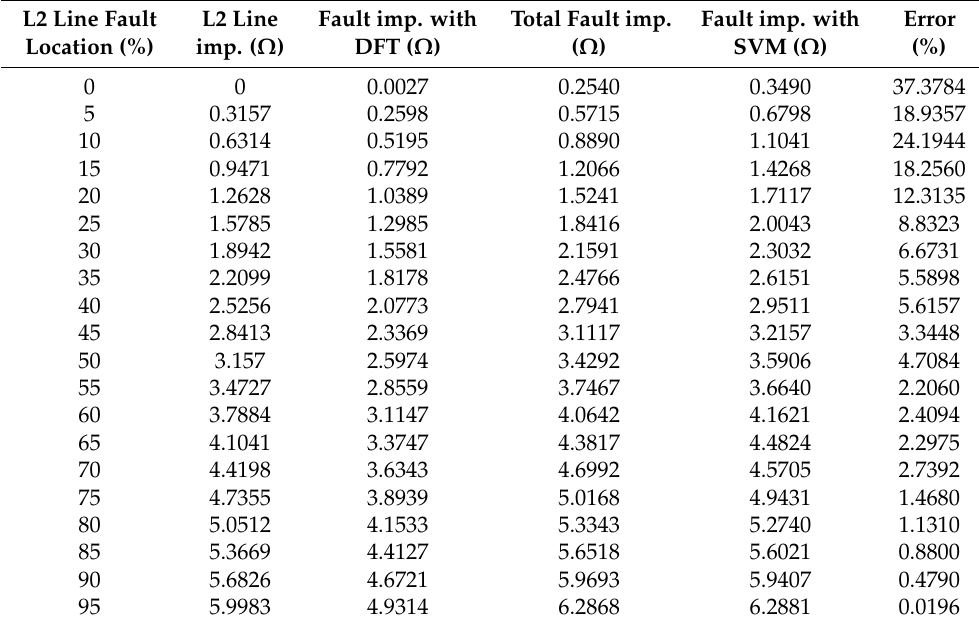
Figure 11. Proposed distance protection with the SVM method. Table 3. Impedance-fault locations for single phase–ground